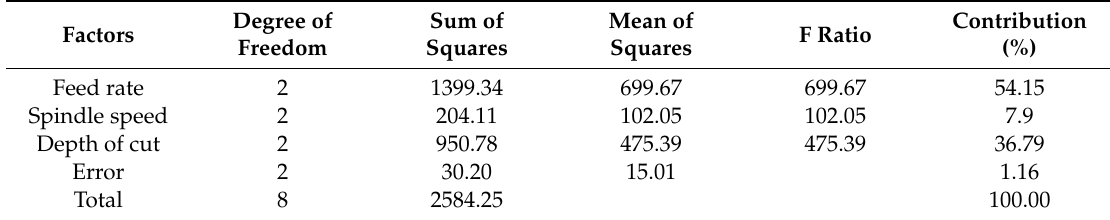
Table 7. Analysis of variance for the cutting force.